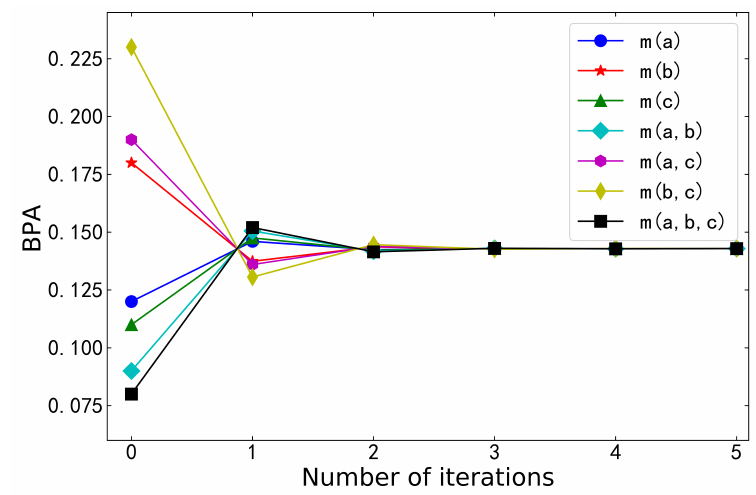
Figure 3. BPA after logarithmic negation iterations in Example 3. Table 3. BPA and entropy after logarithmic negation iterations in Example